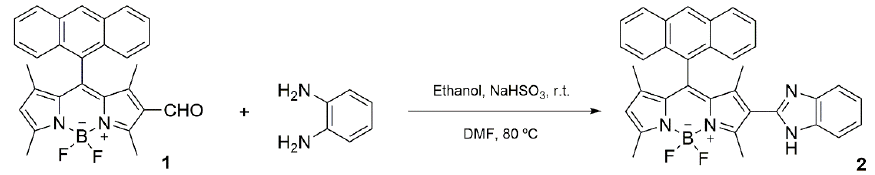
Figure 2. Color change observed for BODIPY derivative 2 in acetonitrile/water (75:25) upon addition of 50 equivalents of several anions.